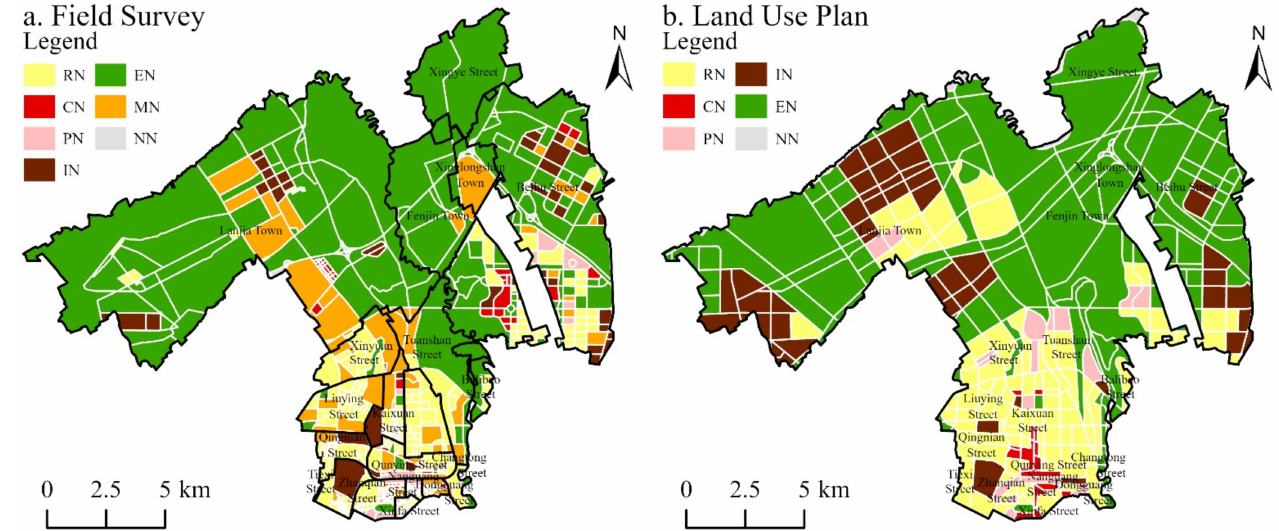
Figure 11. Comparison of ( a ) field survey and ( b ) land-use